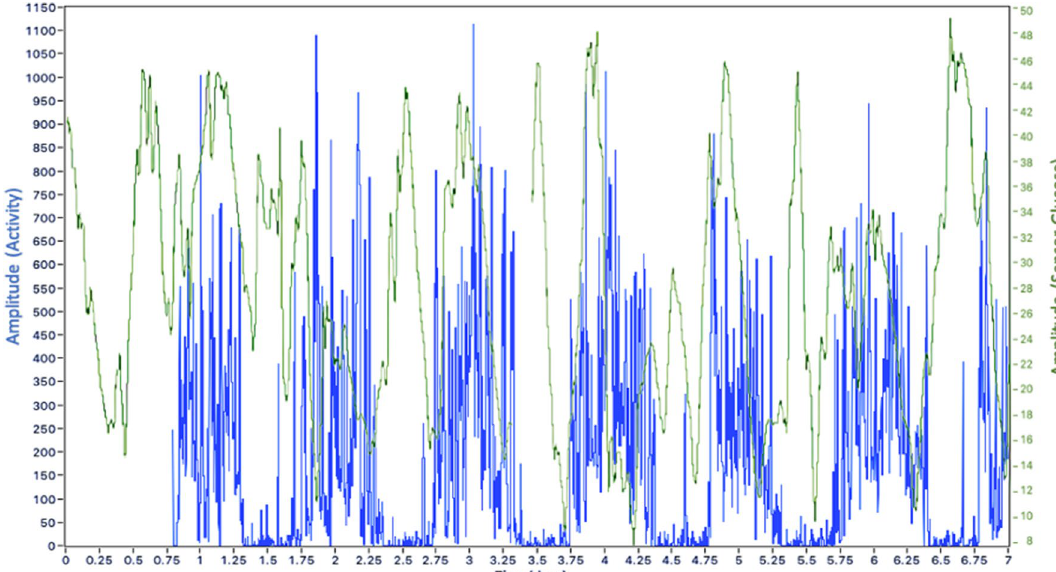
Figure 2. Characteristic patterns of unstructured physical activity and glucose with days and sleep/wake intervals for a single participant. The panel illustrates raw activity (total counts per 5 min [blue]) and glucose values (mean [green]) over a 7-day recording period, with clear daily circadian variations in both activity and glucose.